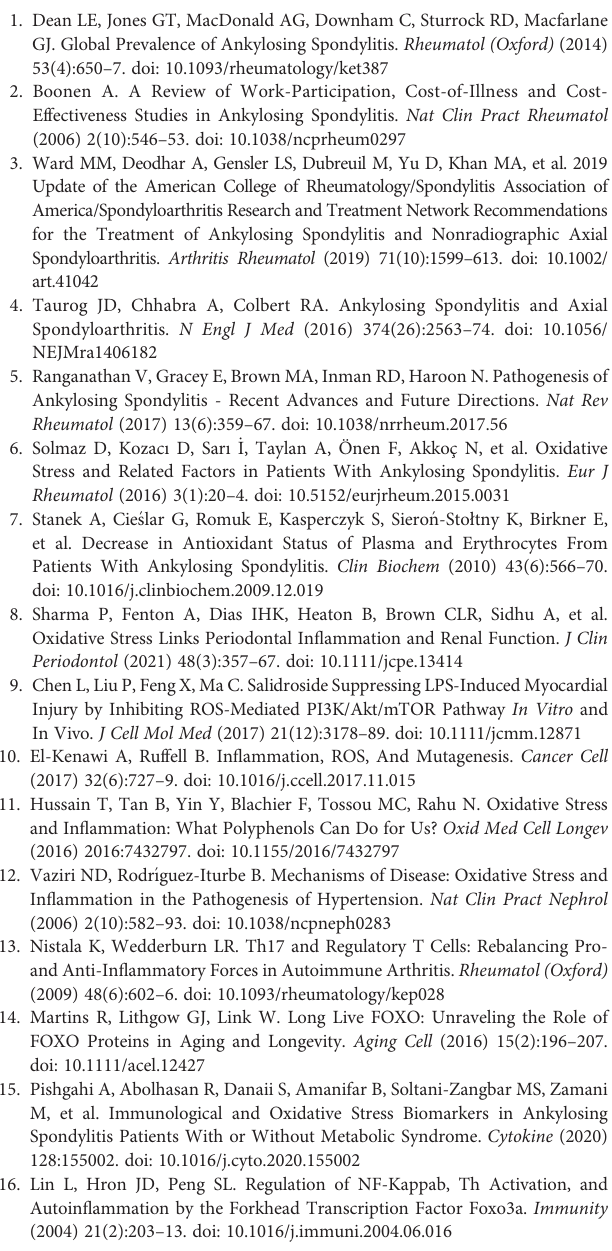
Supplementary Figure 2 | Analysis of candidate promoter region of TGF- b (A, B) and HO-1 (C, D) gene. (A, B) The promoter activity of TGF- b was predicted in BDGP: Neural Network Promoter Prediction (A) and Promoter 2.0 Prediction (B) . (C, D) The promoter activity of HO-1was predicted in BDGP: Neural Network Promoter Prediction (C) and Promoter 2.0 Prediction (D) . Both TGF- b and HO-1 promoter regions showed promoter